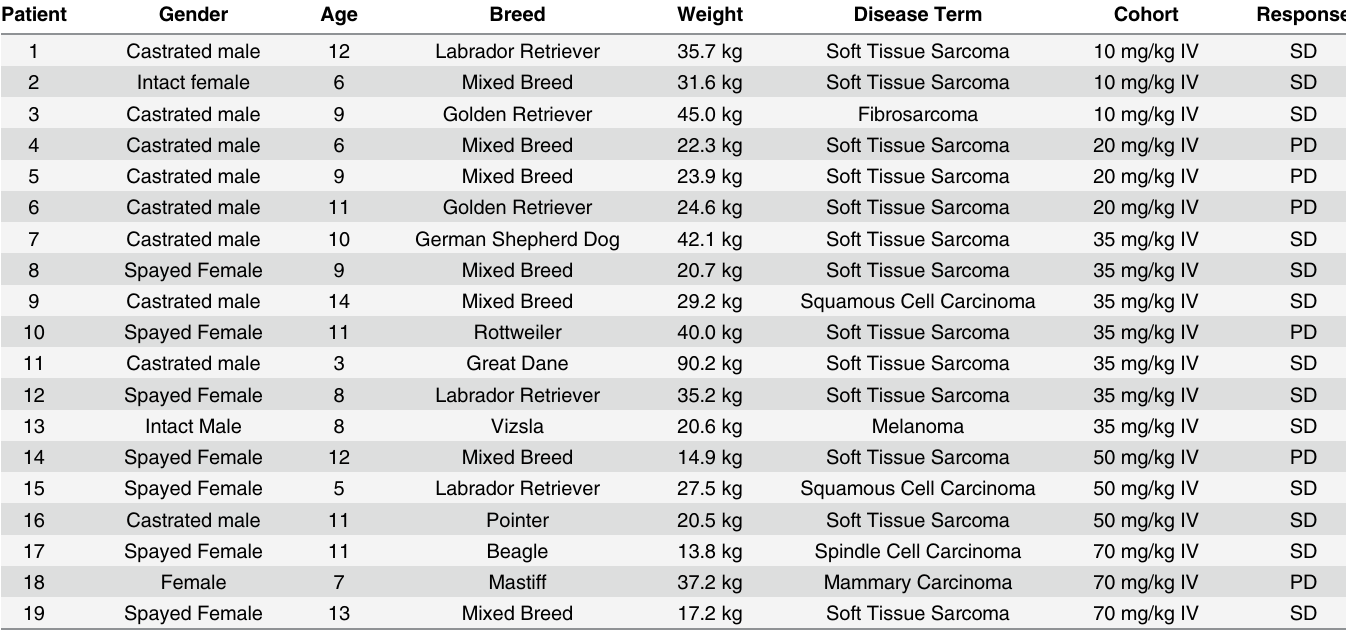
Table 3. Patient